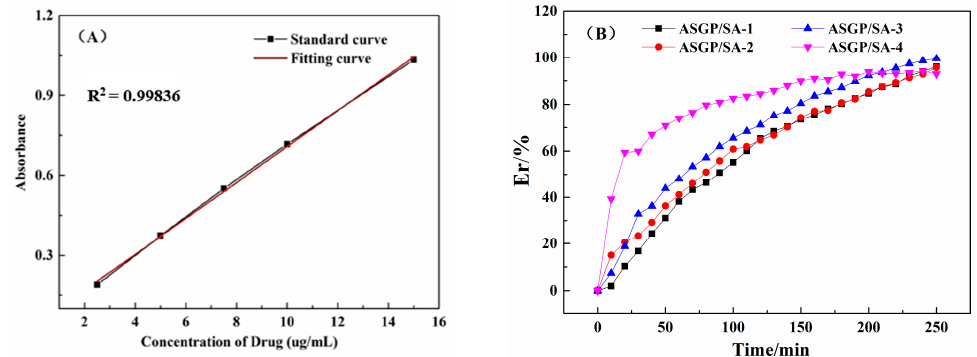
Figure 4. ( A ) Standard curve of MFH and ( B ) The drug − release performance of drug − loaded hydro- gels.